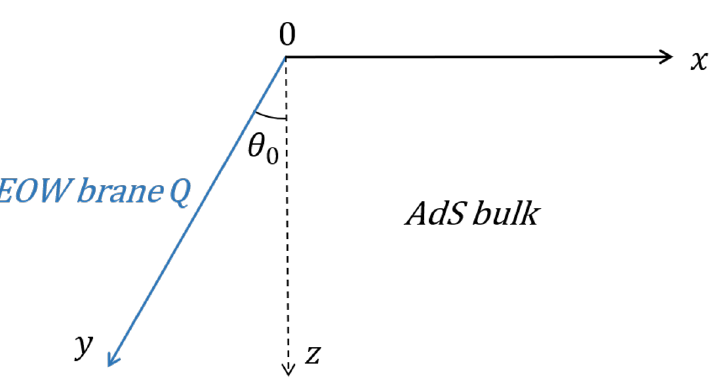
Figure 1. A fixed time slice of the AdS 3 /BCFT 2 setting. The AdS 3 bulk has an End-of-the-World brane Q which can be viewed as a defect. The holographic dual of the bulk is a BCFT defined on half space ( x > 0